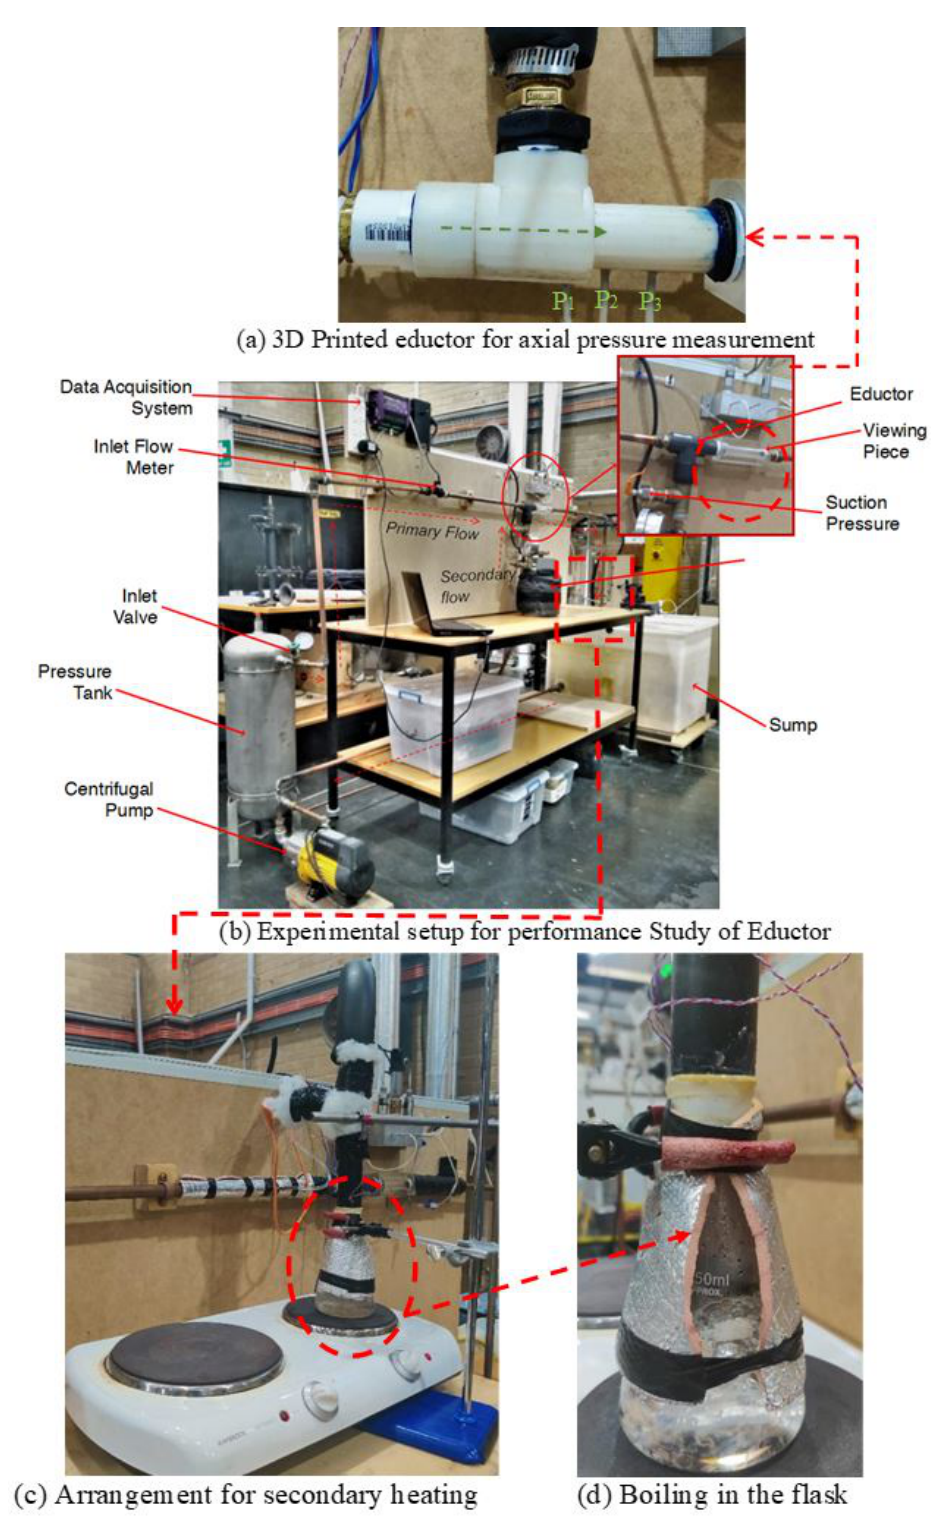
Figure 4. Experimental setup at Thermo-fluid